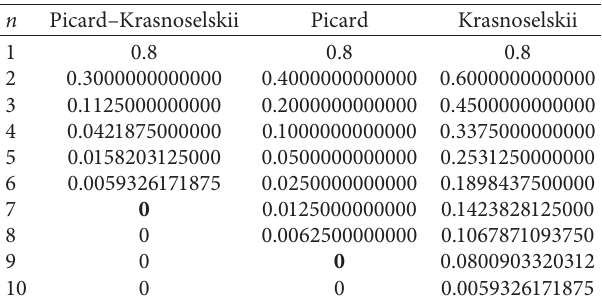
Table 1: Convergence of Picard–Krasnoselskii hybrid, Picard, and Krasnoselskii iterations to the fixed point q � 0.